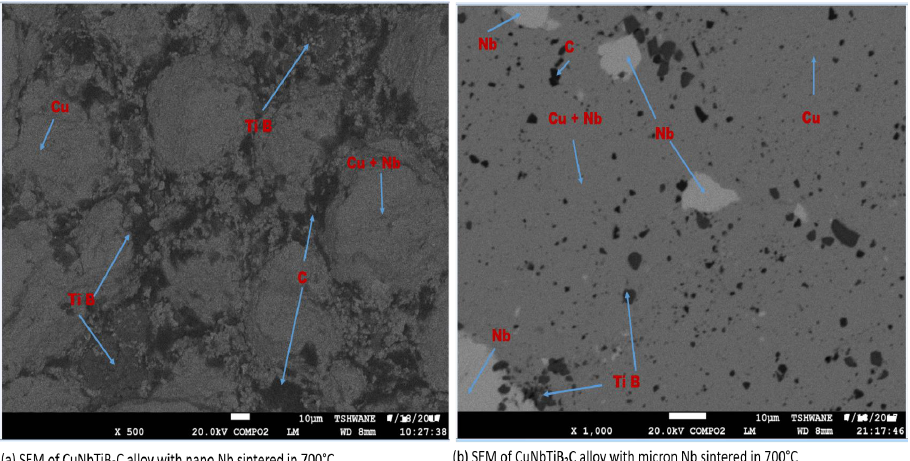
Figure 5. ( a ) and ( b ) compare the SEM of CuNbTiB 2 C alloys with nano and micron both Figure 5. ( a , b ) compare the SEM of CuNbTiB 2 C alloys with nano and micron both sintered at 700 ◦ sintered at 700 °C.